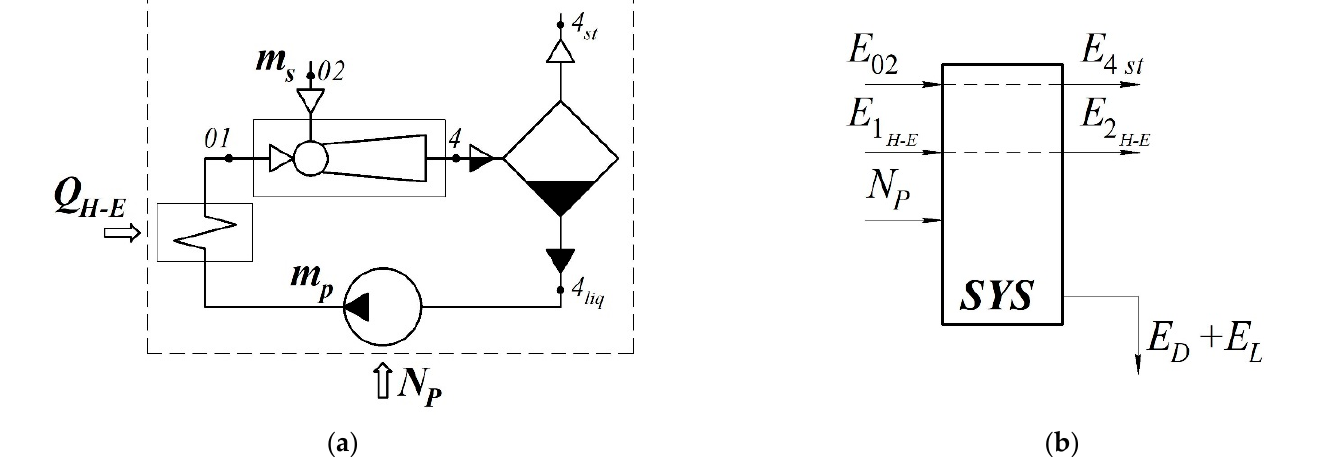
Figure 5. ( a ) “LVE + separator” system diagram and ( b ) scheme of exergy transformations.